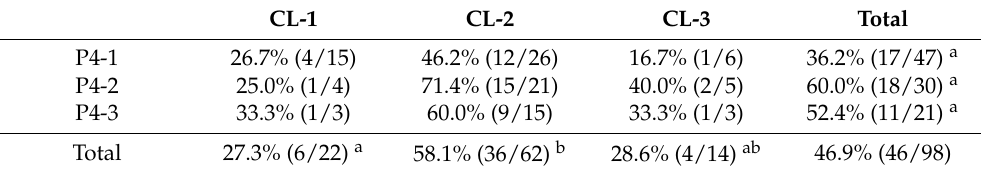
Table 3. Pregnancy rate (pregnant individuals/total ET recipient) according to the CL size and P4 level in 98 cows. The recipients are grouped into CL-1 ( ≤ 1.5 cm), CL-2 (>1.5 cm and ≤ 2.5 cm), and CL-3 (>2.5 cm) by the CL size, and into P4-1 ( ≤ 2.0 ng/mL), P4-2 (>2.0 ng/mL and ≤ 4.0 ng/mL), and P4-3 (>4.0 ng/mL) by the P4 level. Different superscripts within a row and column indicate significant differences between groups, as revealed by